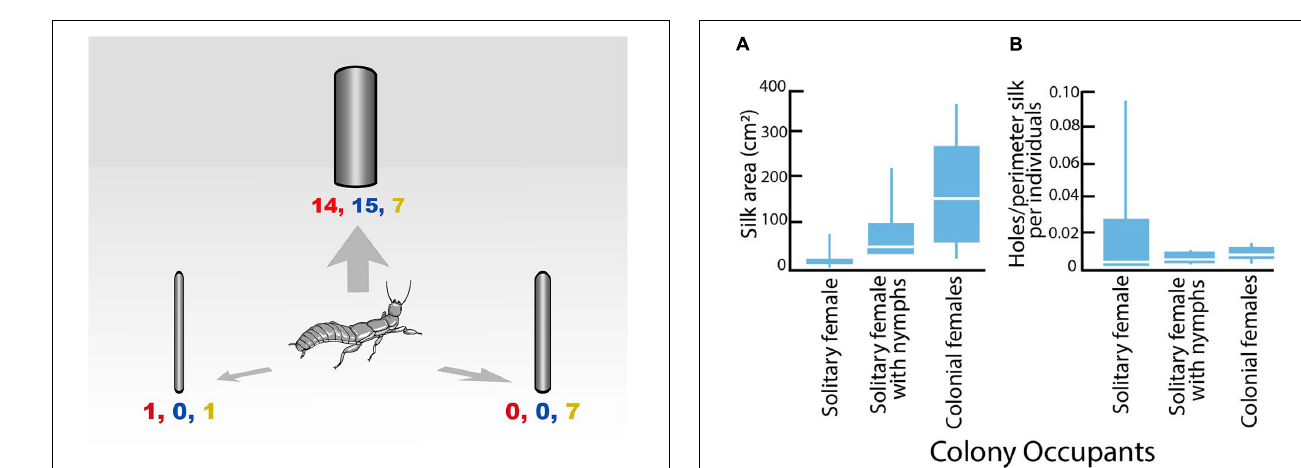
FIGURE 5 | Silk colony sizes and risk of predation for field colonies of Antipaluria urichi . Box plots show medians, quartiles and ranges. Sample sizes: solitary adult females ( n = 7), solitary females with nymphs ( n = 7), and grouped females ( n = 6). (A) Area of silk expanse (cm 2 ) for adult females in the three different colony types. (B) Risk of predation as measured by accumulation of cuts per perimeter of silk covering per individual recorded over 3 weeks in field colonies in the Northern Range Mts of